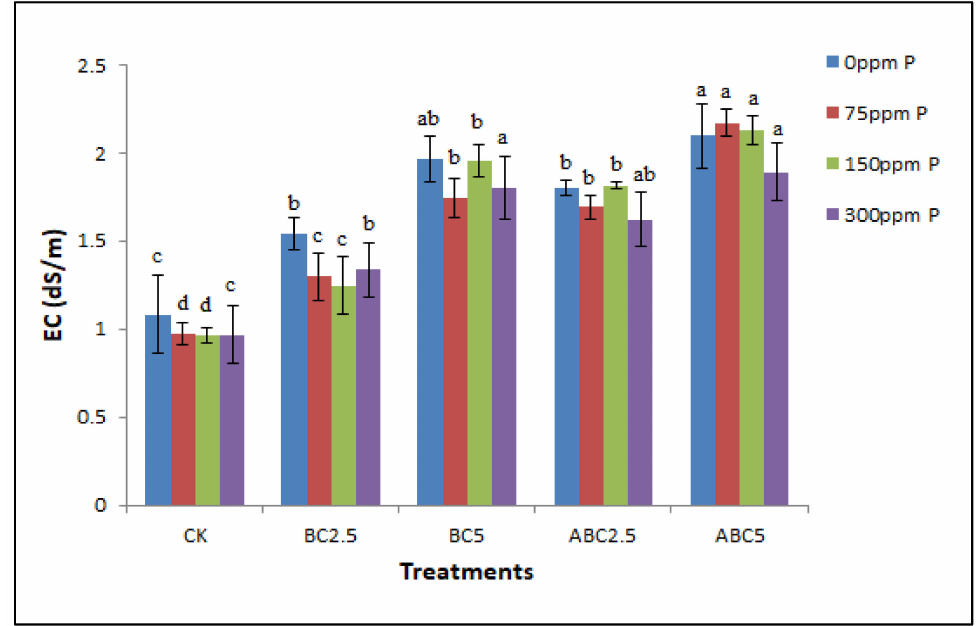
Figure 4. Effects of BC and ABC applied at different rates with different P fertilizer application rates on Soil EC in dS/m. Means with different letters within each fertilizer rate across each treatment indicate significant differences according to the least significant difference (LSD) test at p < 0.05. CK = Control, BC2.5 = Biochar applied at 2.5% w / w , BC5 = Biochar applied at 5% w / w , ABC2.5 = Acidified biochar applied at 2.5% w / w , and ABC5 = Acidified biochar applied at 5% w / w